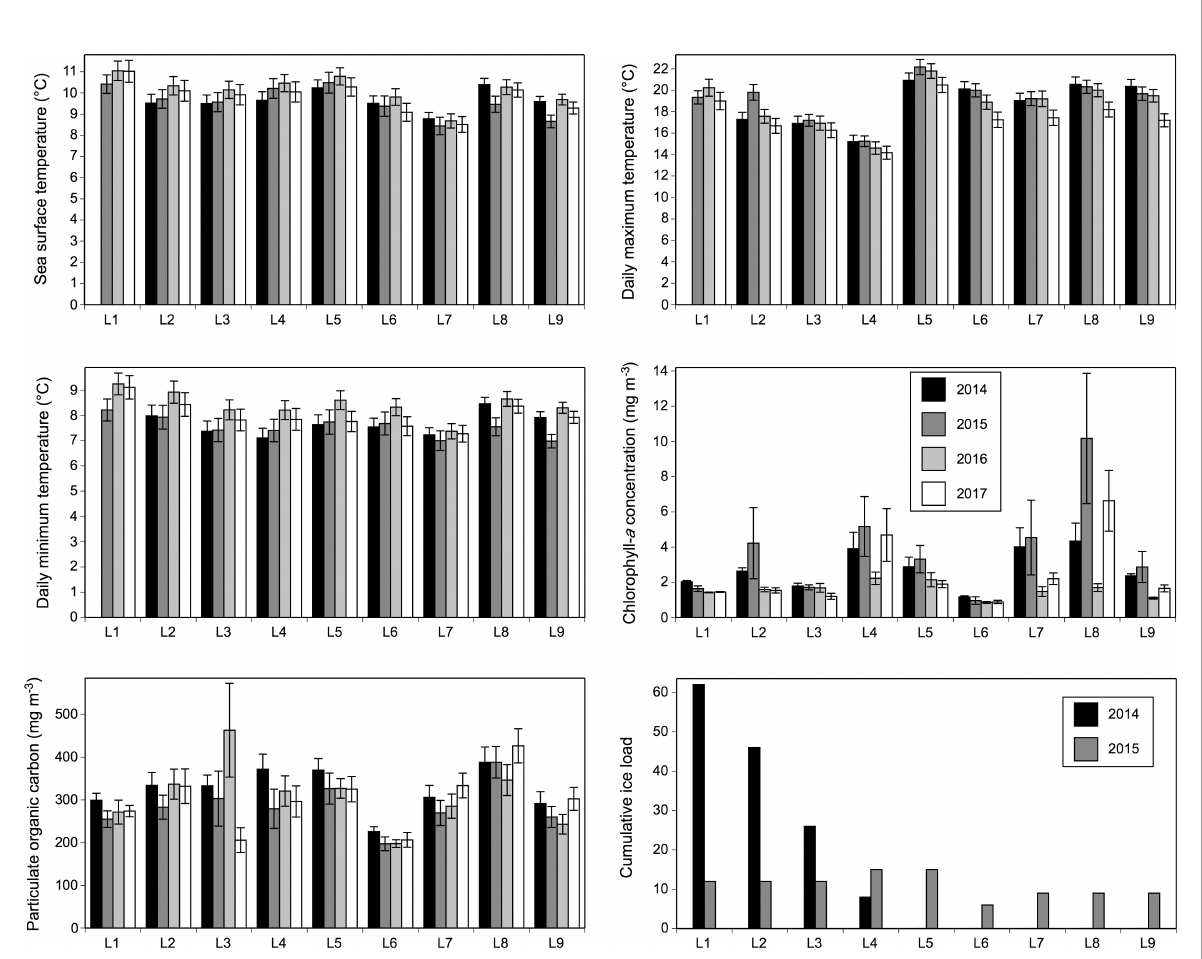
FIGURE 6 Sea surface temperature, daily maximum temperature, daily minimum temperature, chlorophyll- a concentration, and particulate organic carbon (mean ± SE) measured during the growth season and cumulative ice load measured during the cold season for each location and year. See Materials and Methods for the underlying rationale for these